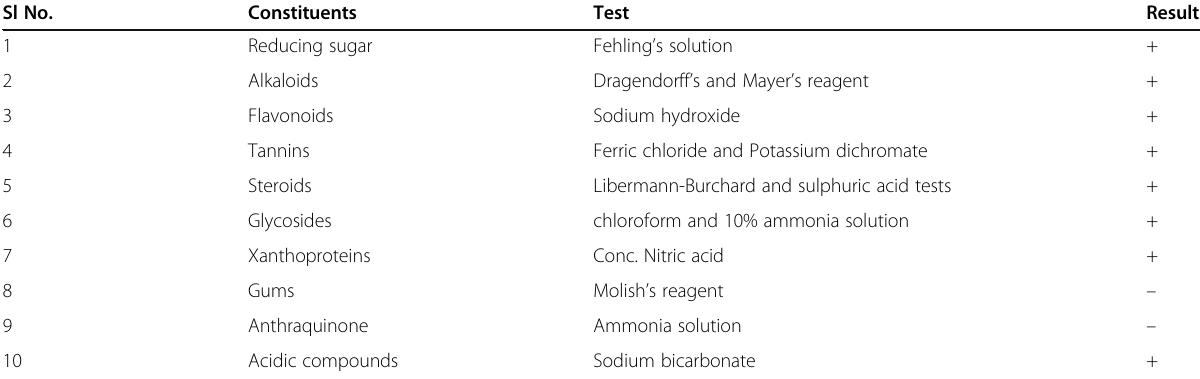
Table 1 Phytochemical constituents of ESMU Sl